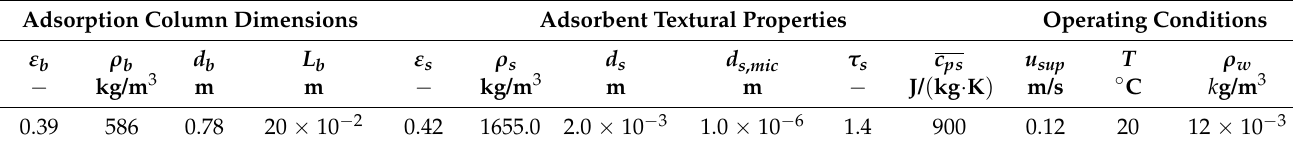
Table 5. Adsorption column dimensions and adsorbent textural properties